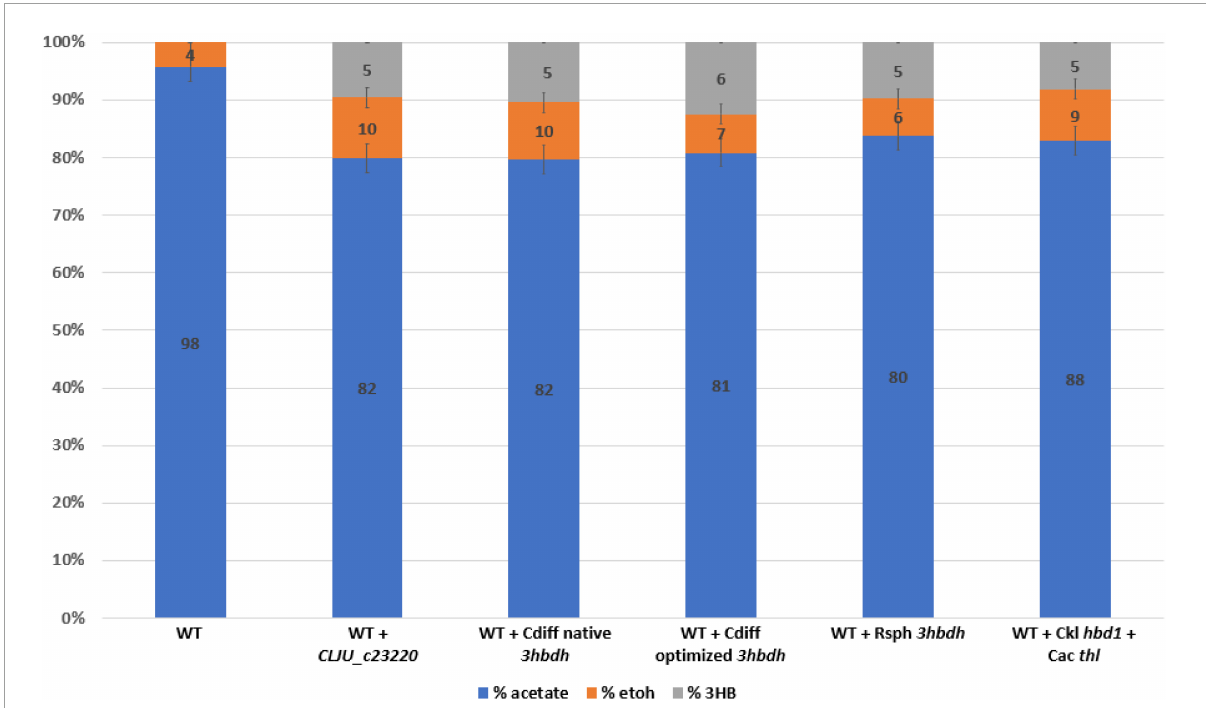
FIGURE2 Heterotrophic 3HB production by Clostridium ljungdahlii strains expressing different 3HB pathways. Carbon distribution of fermentation products is indicated by the bar chart %, while the number label is the mM amount after 5 days of growth. In addition to the thiolase ( thl ) and CoA transferase, four genes were expressed on separate replicating plasmids. A codon optimized 3-Hydroxybutyrate dehydrogenase ( 3hbdh ) from R. sphaeroides (Rsph), from C. difficile (Cdiff), native and codon optimized, and Clju_C23220 were expressed. Note that the C. ljungdahlii gene expressed is not a true 3HB Dehydrogenase (see text). A separate plasmid containing only C. kluyveri hbd1 and C. acetobutyulicum thiolase ( thl ) was also expressed. Error bars show standard error of the mean (SEM) for 3 biological replicates.